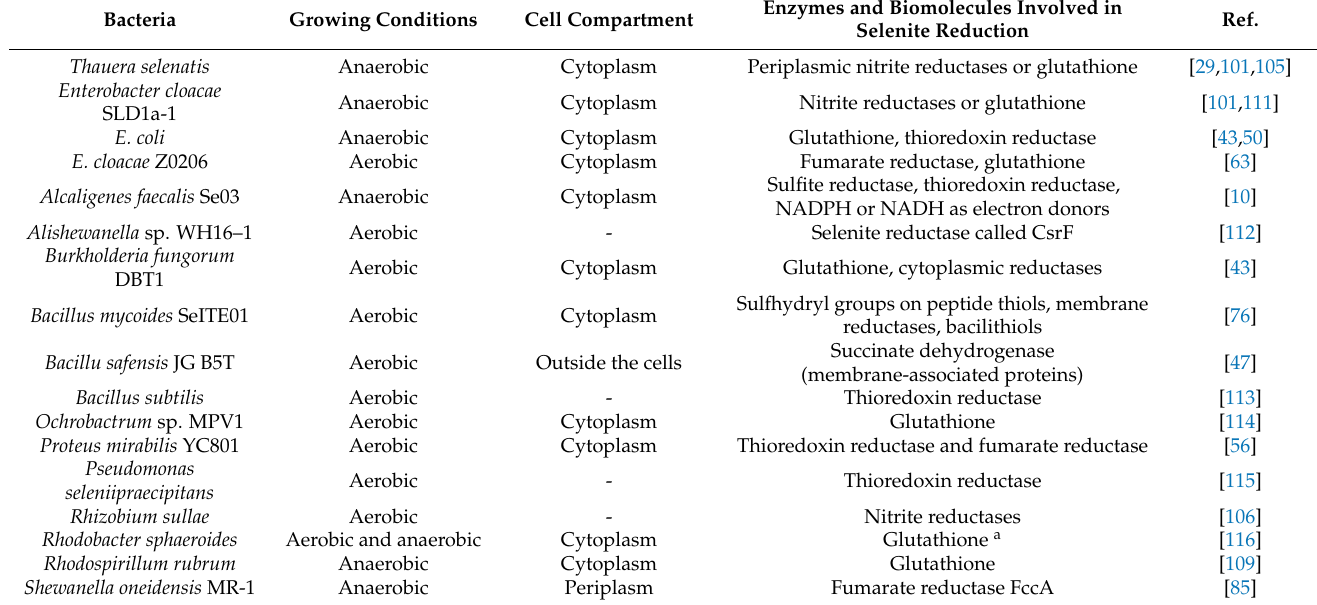
Table 4. Enzymes involved in the reduction of selenite to Se 0